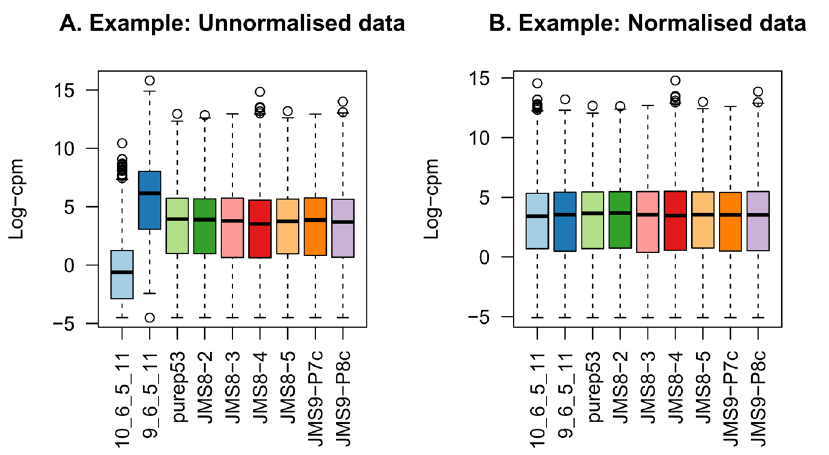
Figure 2. Example data: Boxplots of log-CPM values showing expression distributions for unnormalised data ( A ) and normalised data ( B ) for each sample in the modified dataset where the counts in samples 1 and 2 have been scaled to 5% and 500% of their original values